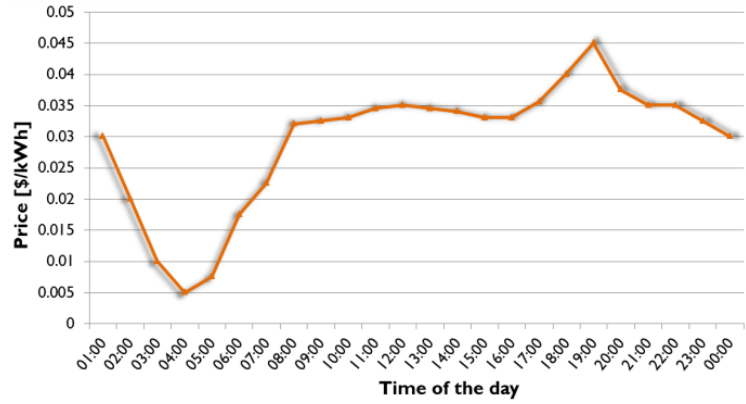
Figure 8. Dynamic pricing of buying energy from a grid.